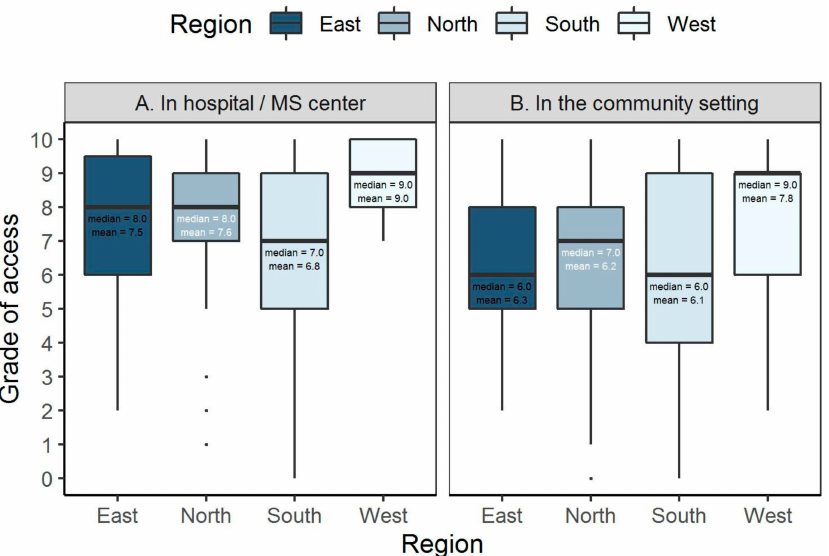
Figure 2. Perceived accessibility of multiple sclerosis (MS) physiotherapy by region A. In hospital /